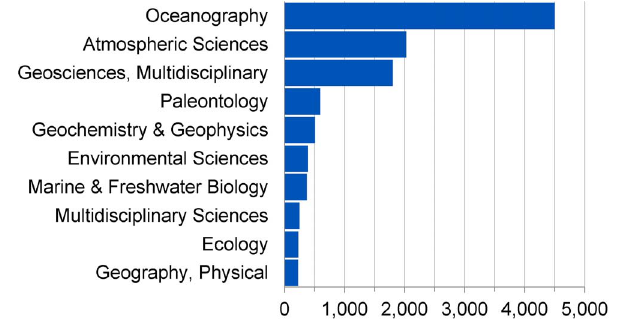
Figure 3. Number of articles citing all versions of the WOA/ WOD per WoS-defined subject category.